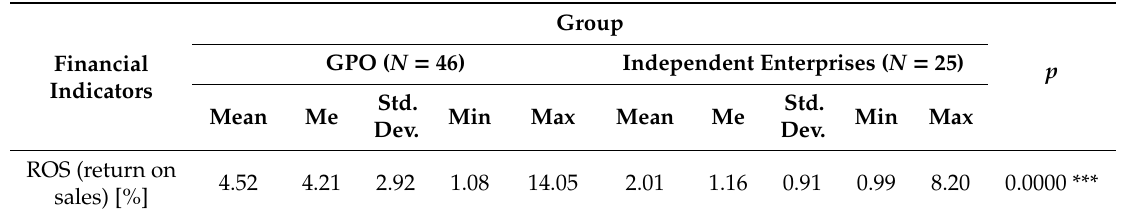
Table 1. Profitability ratios for the enterprises analysed